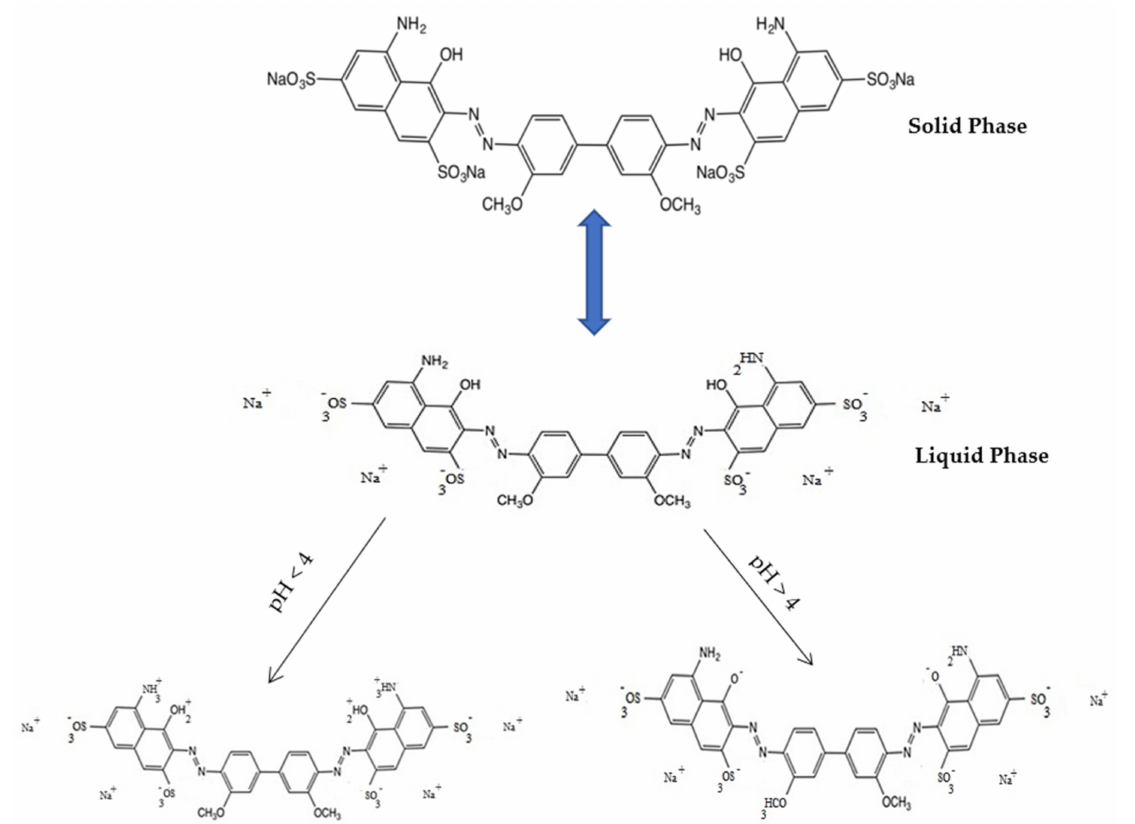
Figure 6. Structures of Direct Blue 15 dye in an aqueous